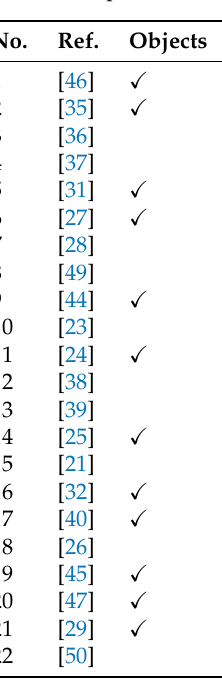
Table 6. Computer vision tasks approached for each accepted paper, clustered into four broad